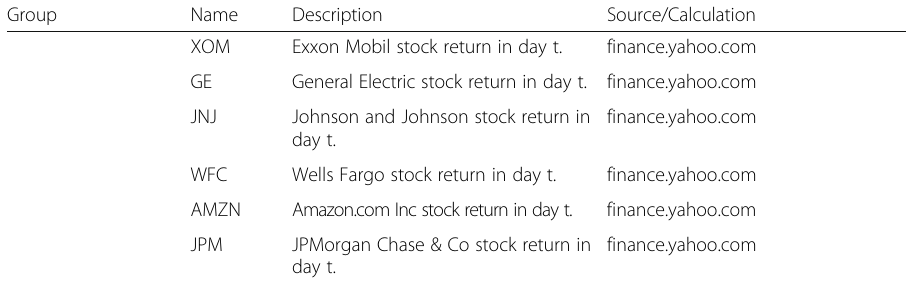
Table 10 The 60 financial and economical features of the raw data (Continued)